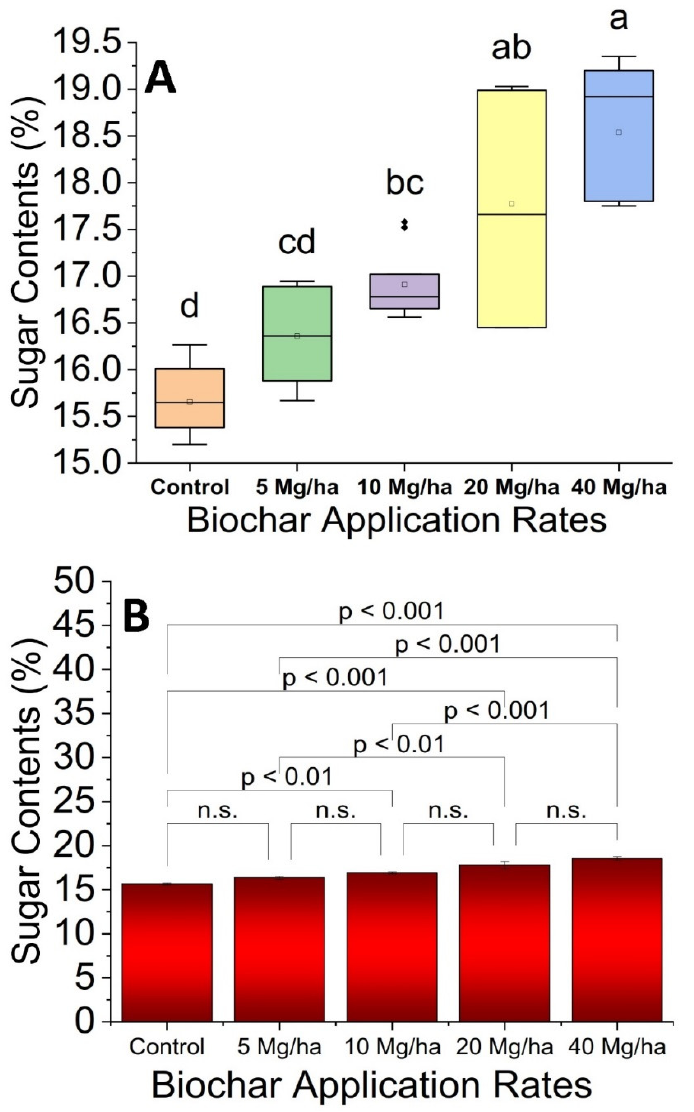
Figure 5. Effect of different biochar application rates on mango fruit sugar contents. Bars are mean of 9 replicates. Different letters show a significant difference at p ≤ 0.05 ( A ). Probability value hierarchy for fruit sugar contents is provided in ( B ).